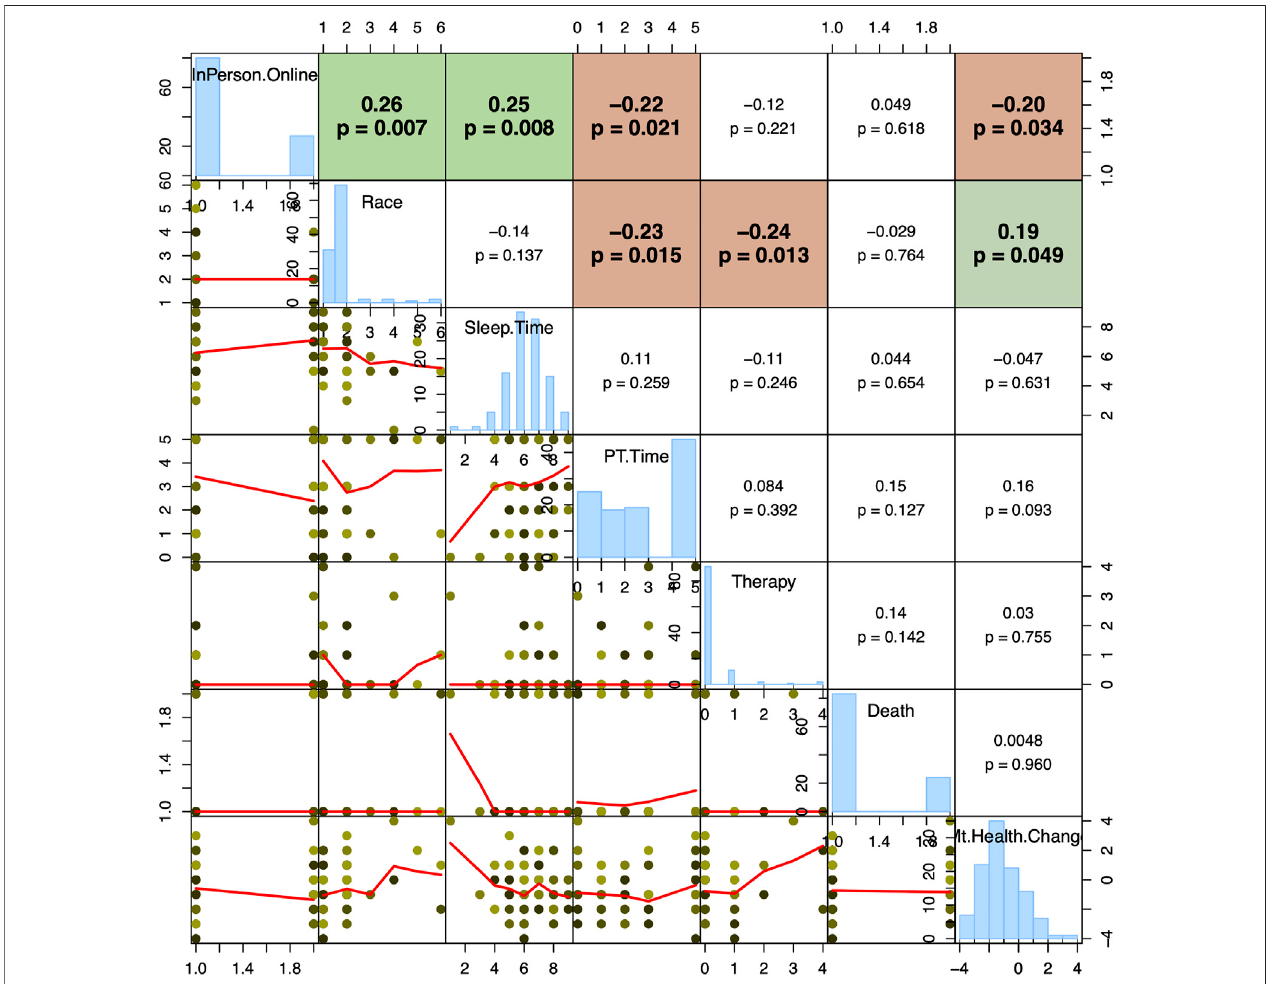
FIGURE 6 | Key subset of results from correlation analysis. The values in the upper-right triangle show the Spearman correlation between pairs of values. For example, 0.19 ( p (cid:1) 0.049) shows the correlation between Race (the row) and Mt.Health.Change (column). The red lines in the scatter plots show the Lowess curve to highlight correlation patterns within sub-ranges of data. The full correlogram with all stressors (independent variables), controls (pre-existing conditions), and mental health estimators (dependent variables) is included in the supplementary materials.